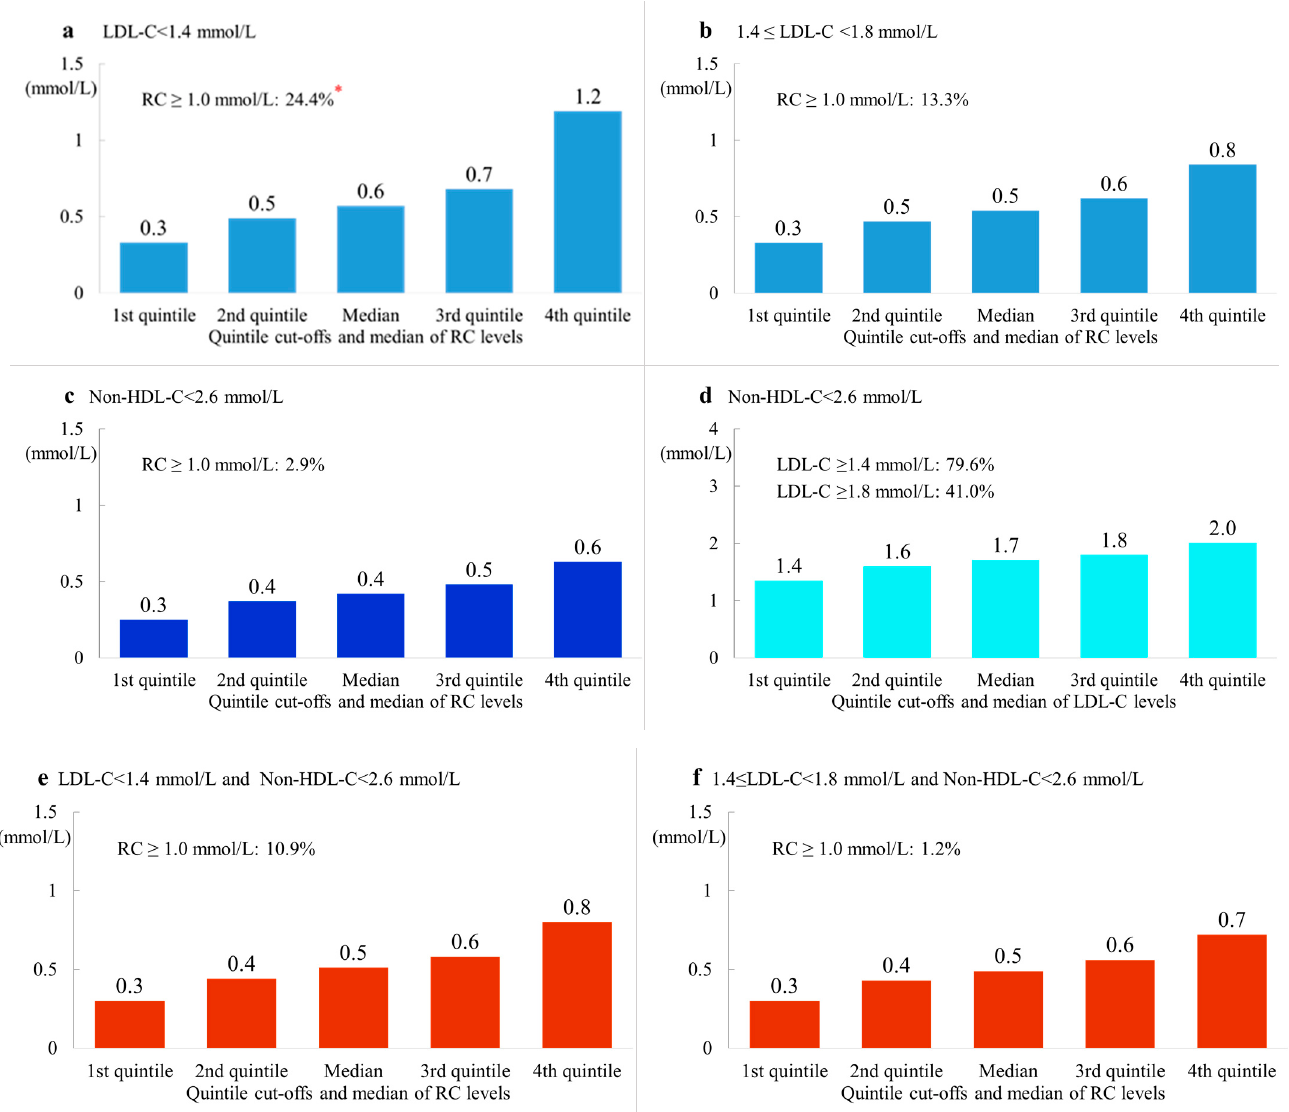
Figure 3. ( a ) Quintile cut-off values and the proportion of elevated remnant cholesterol concentra- tions in patients with LDL-C concentrations < 1.4 mmol/L. ( b ) Quintile cut-off values and the pro- portion of elevated remnant cholesterol concentrations in patients with LDL-C concentrations of 1.4–1.7 mmol/L. ( c ) Quintile cut-off values and the proportion of elevated remnant cholesterol con- centrations in patients with non-HDL-C concentrations < 2.6 mmol/L. ( d ) Quintile cut-off values and the proportion of elevated LDL-C concentrations in patients with non-HDL-C concentrations < 2.6 mmol/L. ( e ) Quintile cut-off values and the proportion of elevated remnant cholesterol concentra- tions in patients with LDL-C concentrations < 1.4 mmol/L and non-HDL-C concentrations < 2.6 mmol/L. ( f ) Quintile cut-off values and the proportion of elevated remnant cholesterol concentra- tions in patients with LDL-C concentrations of 1.4–1.7 mmol/L and non-HDL-C concentrations < 2.6 mmol/L. *, proportion of patients with remnant cholesterol ≥ 1.0 mmol/L. LDL-C, low-density lipo- protein cholesterol; non-HDL-C, non-high-density lipoprotein cholesterol; RC, remnant cholesterol. Table 2. Subgroup analysis of the proportion of patients with elevated remnant cholesterol or LDL- C concentrations in those who reached different treatment targets (%).